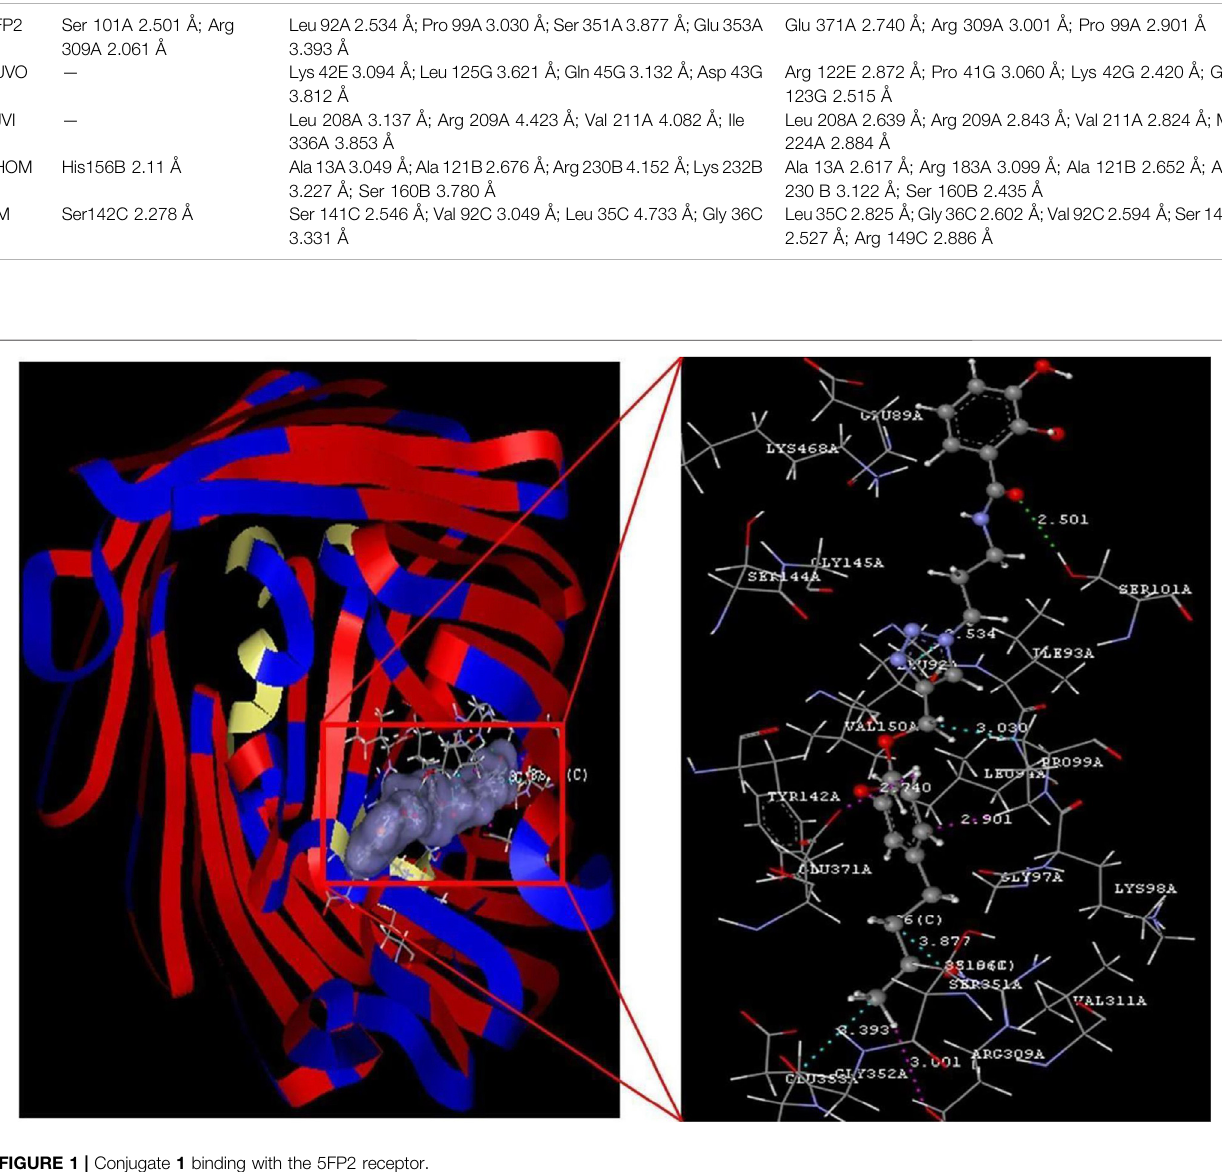
FIGURE 1 | Conjugate 1 binding with the 5FP2